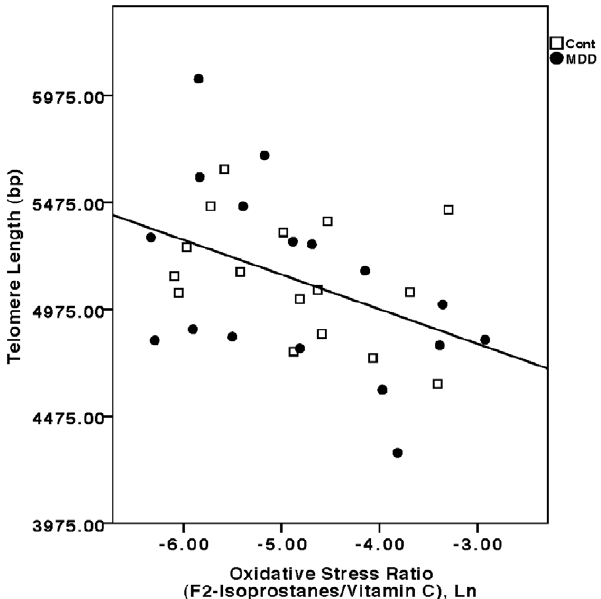
Figure 2. Relationship between the oxidative stress ratio (F-2 isoprostanes/Vitamin C concentrations, Ln transformed) and leukocyte telomere length (in base pairs, bp). Filled circles represent depressed subjects (‘‘MDD’’) (F= 6.04, p , 0.01, controlling for age and sex), and open squares represent controls (‘‘Cont’’) (F= 4.38, p , 0.05, controlling for age and sex). In the combined sample (depressed plus controls), the relationship was also statistically significant (F= 8.21, p , 0.001, controlling for age and sex).